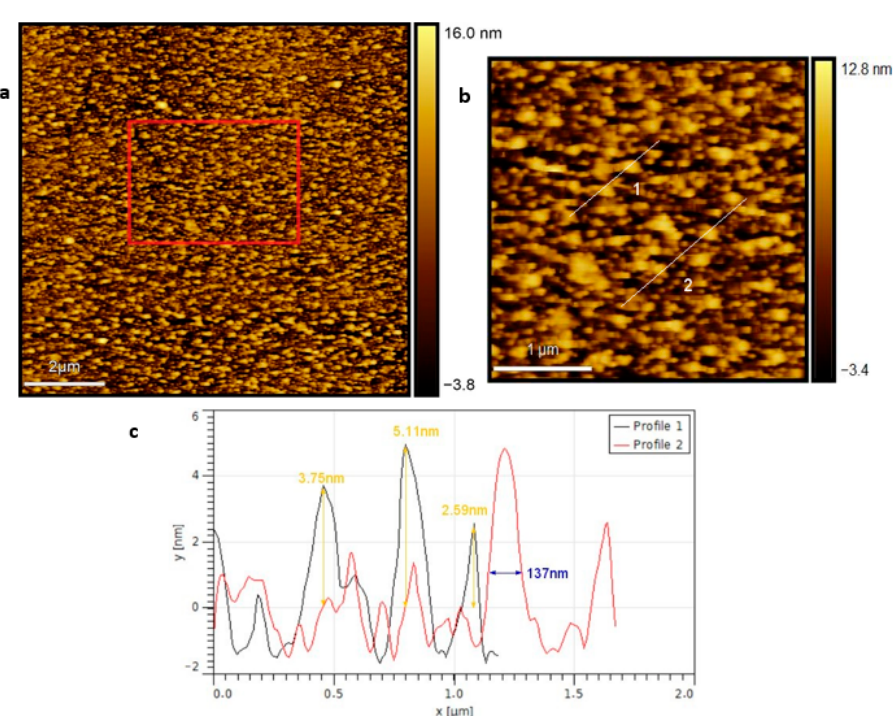
Figure 2 . AFM images of 4 ML MoS 2 : ( a ) 10 × 10 µm scan. ( b ) Magnified region from red box in ( a ). ( c ) Height profiles of magnified regions along lines 1 and 2 from ( b ).